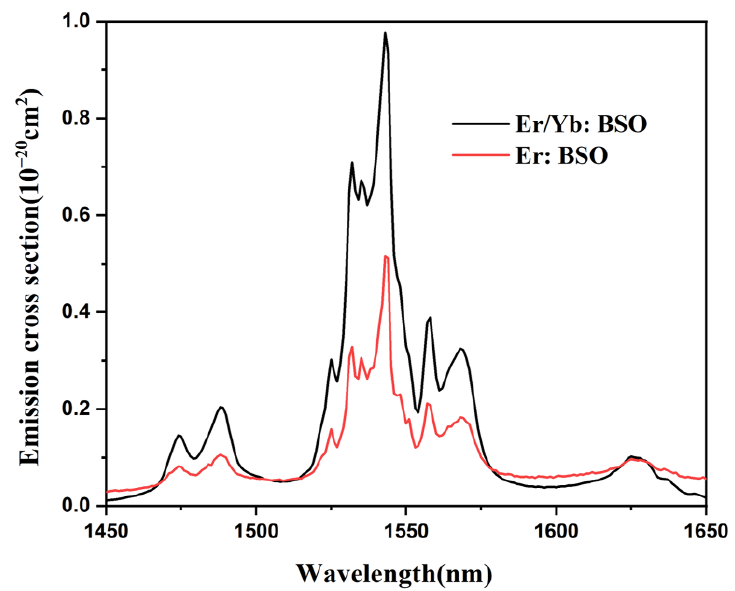
Figure 7. Emission cross-sections for 4 I 13/2 → 4 I 15/2 transition of Er 3+ in Er: BSO and Er/Yb: BSO crys- tals.